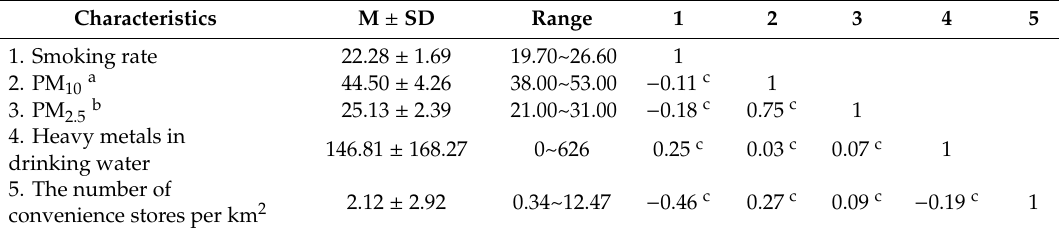
Table 2. Regional characteristics (N =